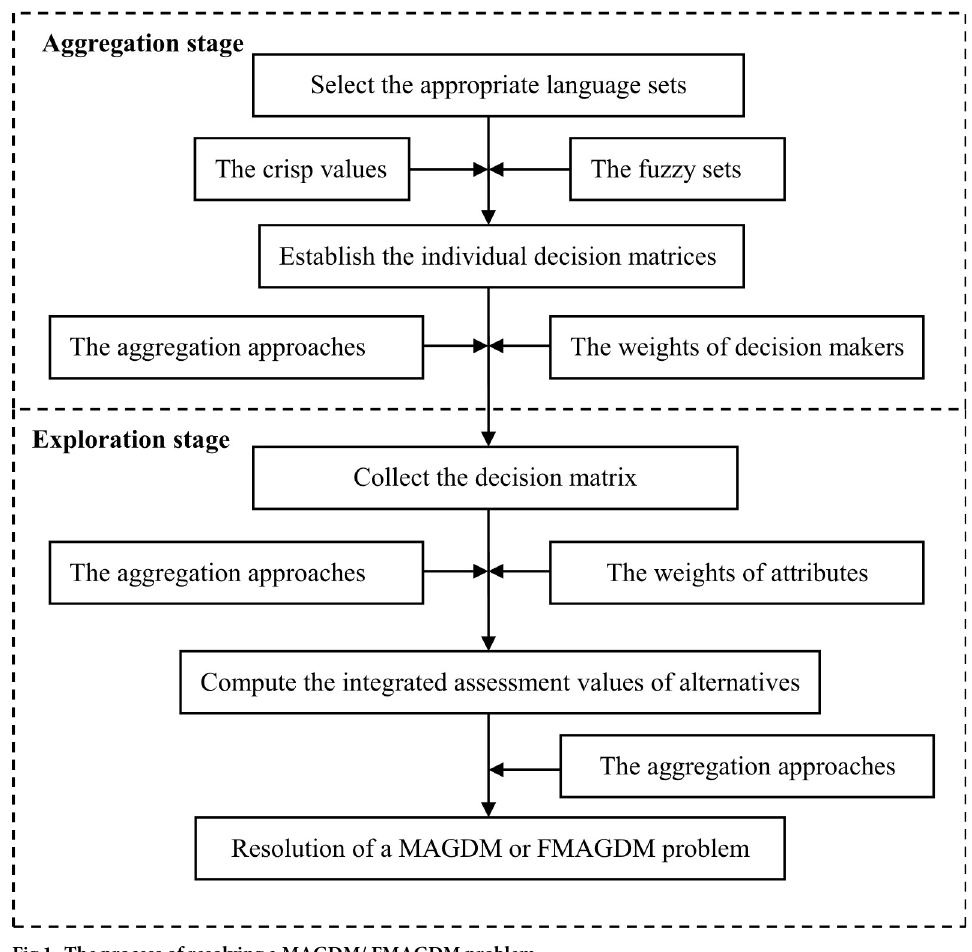
Fig 1. The process of resolving a MAGDM/ FMAGDM